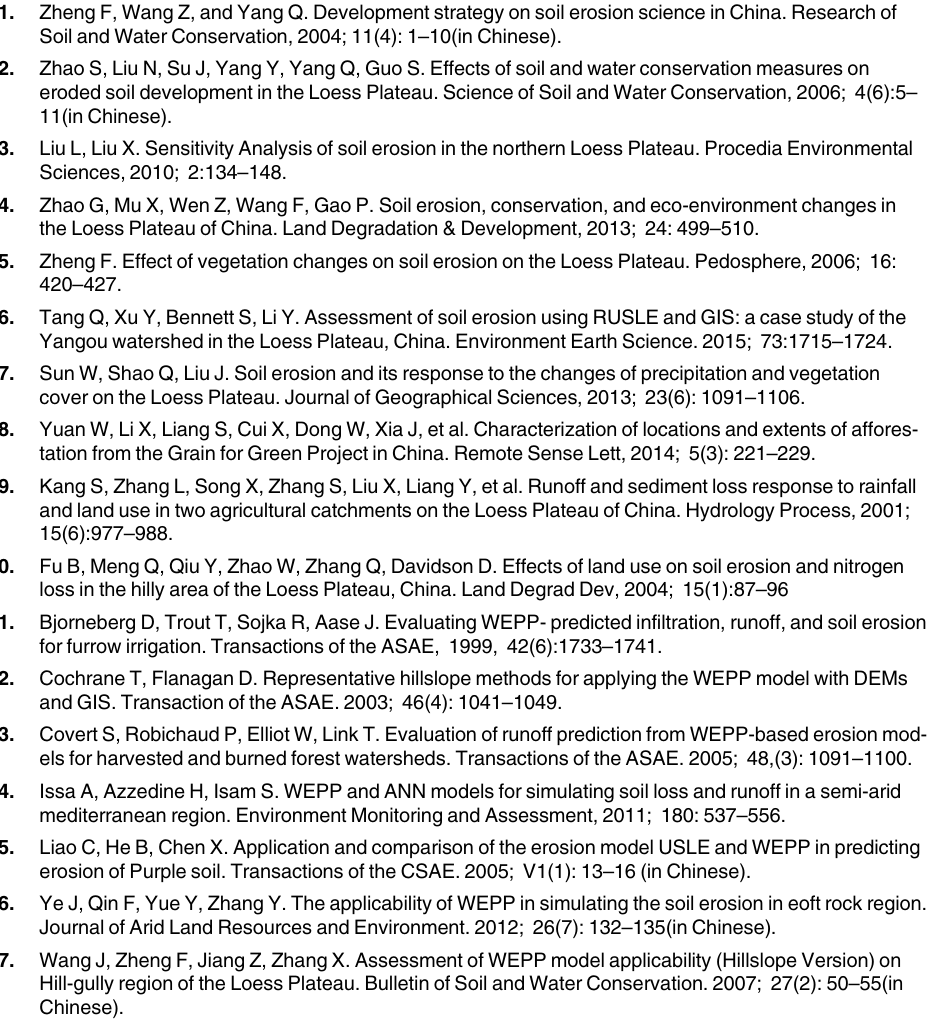
S1 File. Table A: Characteristics of single event storms. Table B: Soil parameters used for each soil type and treatment in the plots and watershed. Fig A: The land use, elevation and soil GIS layers for the watershed (these map was obtained from our measured GPS